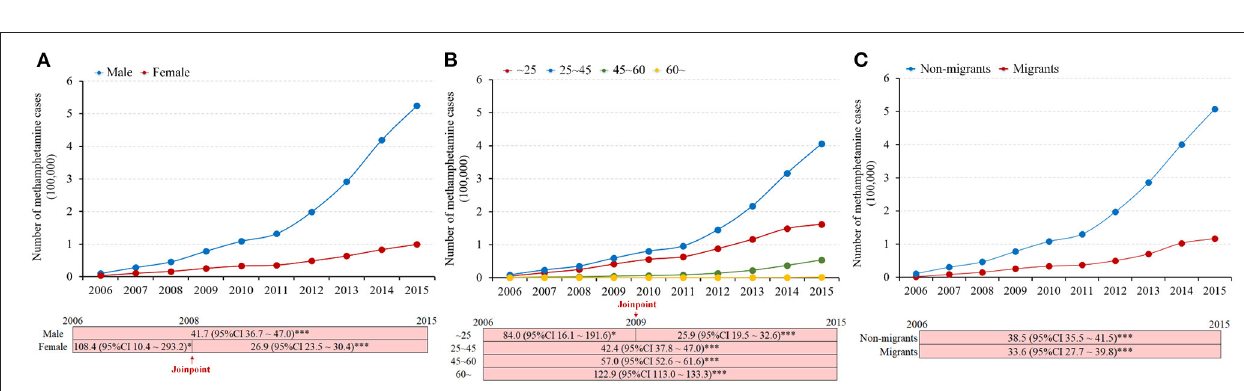
FIGURE 1 | Trends in the annual number and rate of methamphetamine use cases: 2006–2015 in the mainland of China (***indicated p < 0.001).